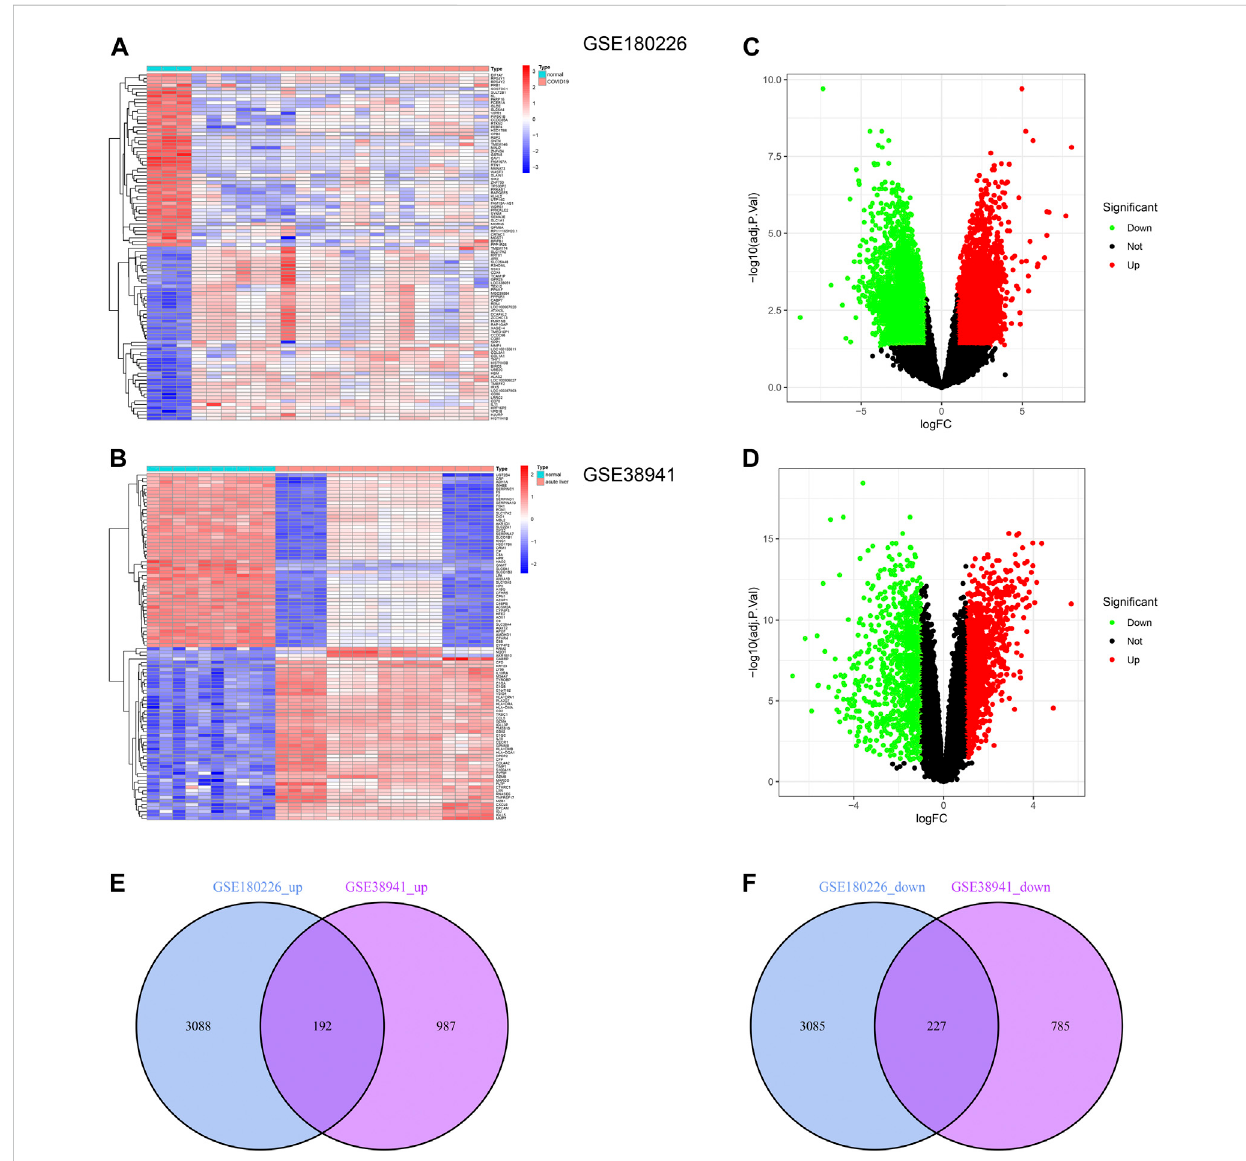
FIGURE 1 Identi fi cation of common DEGs between COVID-19 and ALF. (A) Heatmap of the DEGs in COVID-19 patients compared with healthy controls. (B) Heatmap of the DEGs in ALF patients compared with healthy controls. (C) Volcano plot of DEGs in COVID-19 patients, in which green represents downregulatedDEGs,redrepresentsupregulatedDEGs,andblackrepresentsnodifference. (D) VolcanoplotofDEGsinALF.Andthecolorsrepresentthe same sample as B. (E) Venn diagram showing the upregulated DEGs between COVID-19 and ALF patients. (F) Venn diagram showing the downregulated DEGs between COVID-19 and ALF